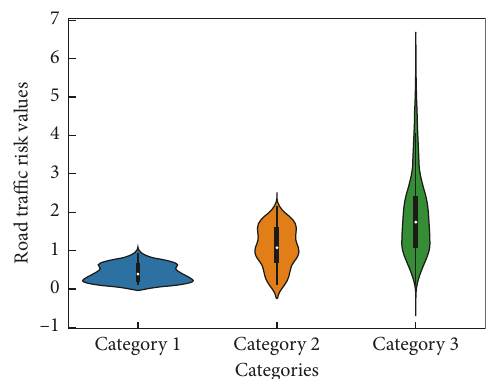
Figure 6: Category risk distribution